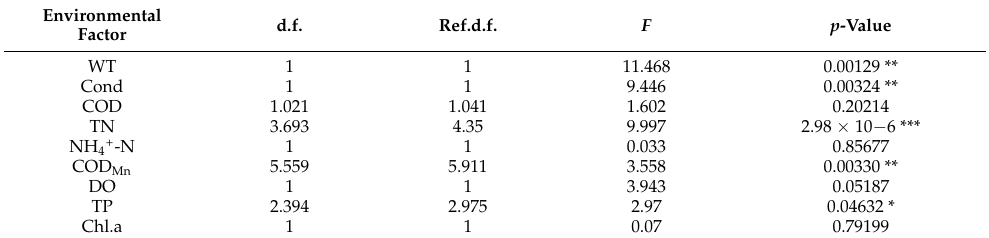
Table 6. GAMmodelanalysisofTOCconcentrationandenvironmentalfactorsintheDanjiangkouReservoir. Environmental Factor